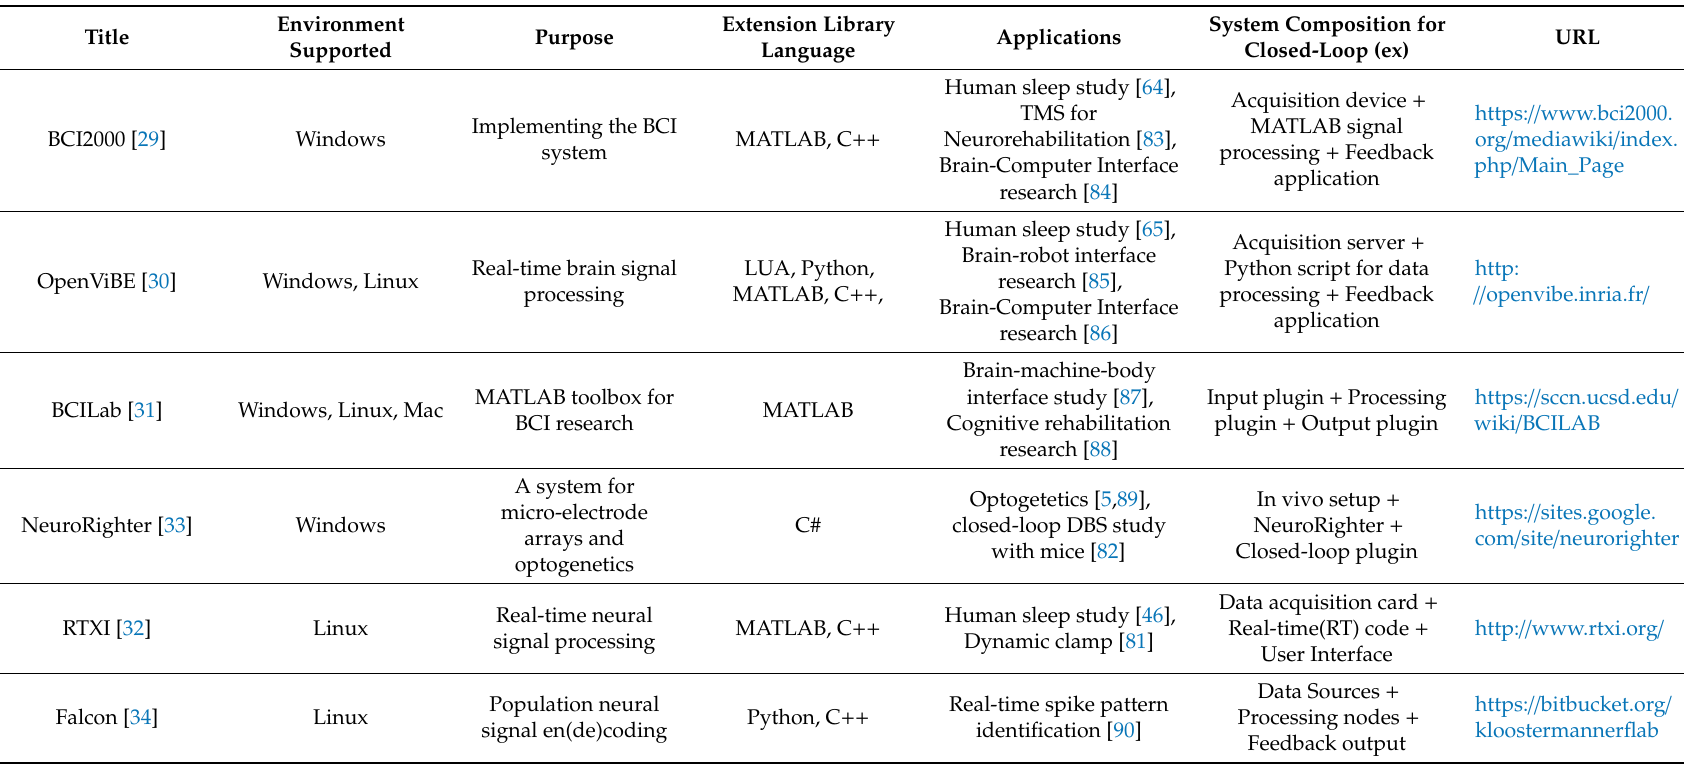
Table 2. Open-source platforms that are used widely as control platforms for a closed-loop feedback